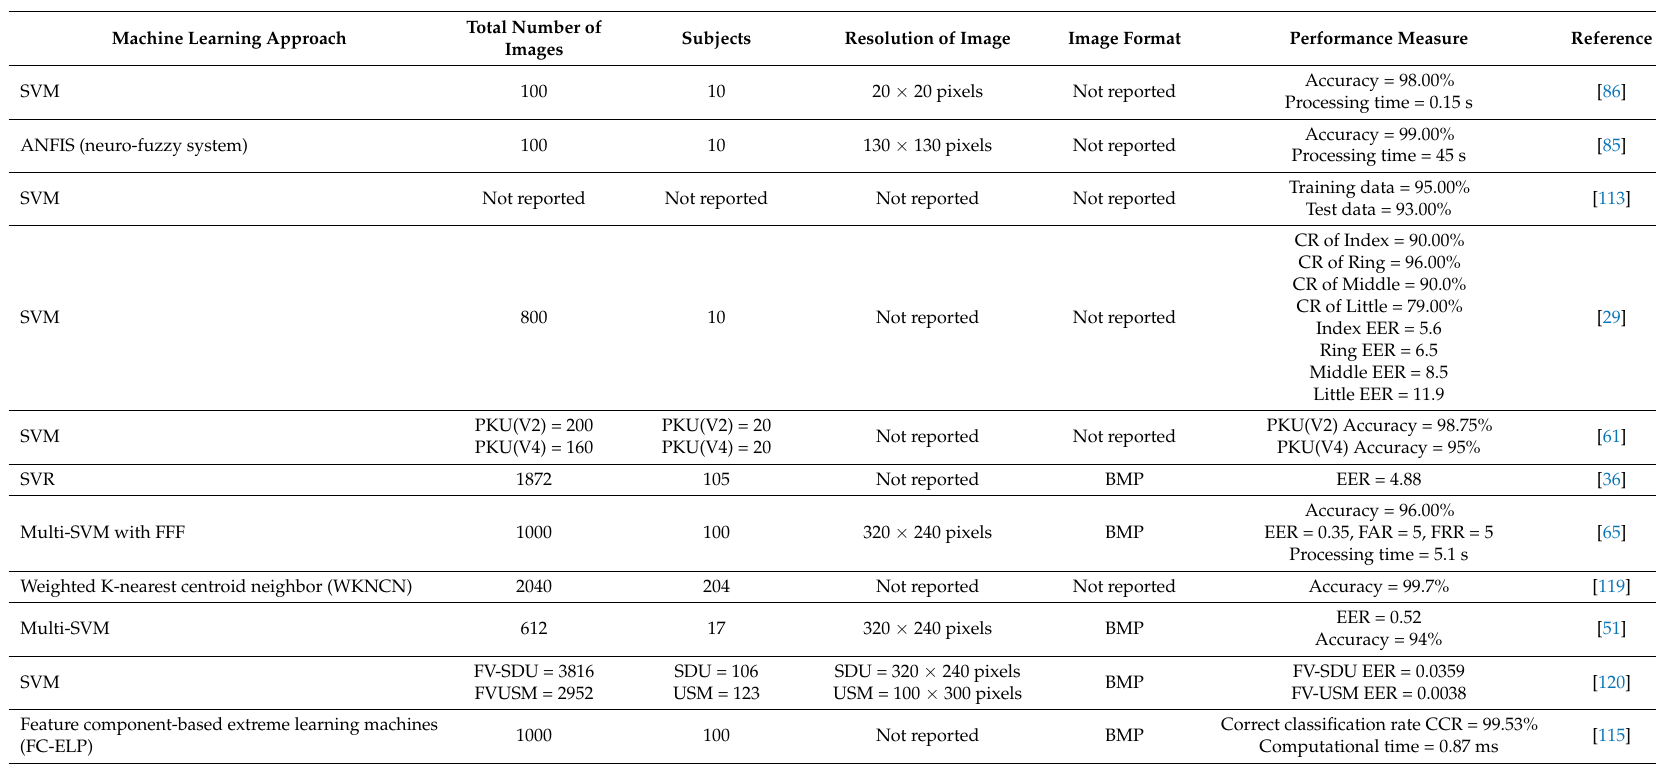
Table 6. Finger vein recognition performance using traditional machine learning